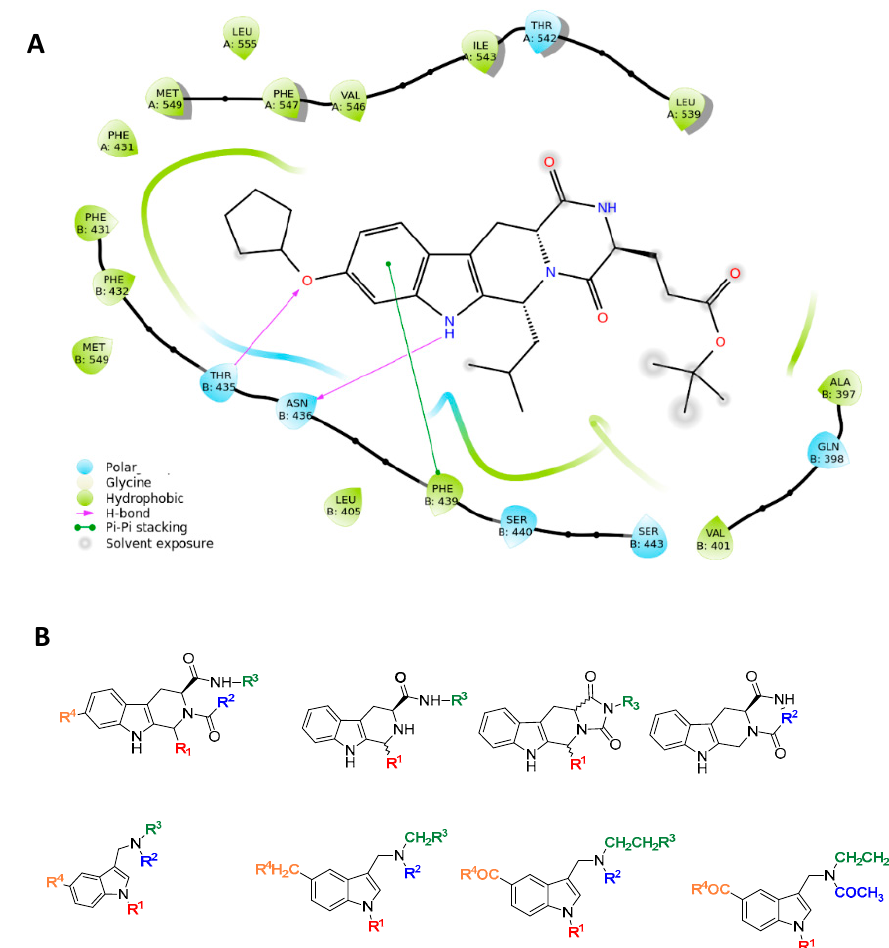
Figure 2. Rational design of ABCG2 inhibitors: ( A ) 2D interaction diagram of MZ29-ABCG2 complex (PDB ID: 6ETI); ( B ) tetrahydro- β -carboline and indole-based scaffolds.